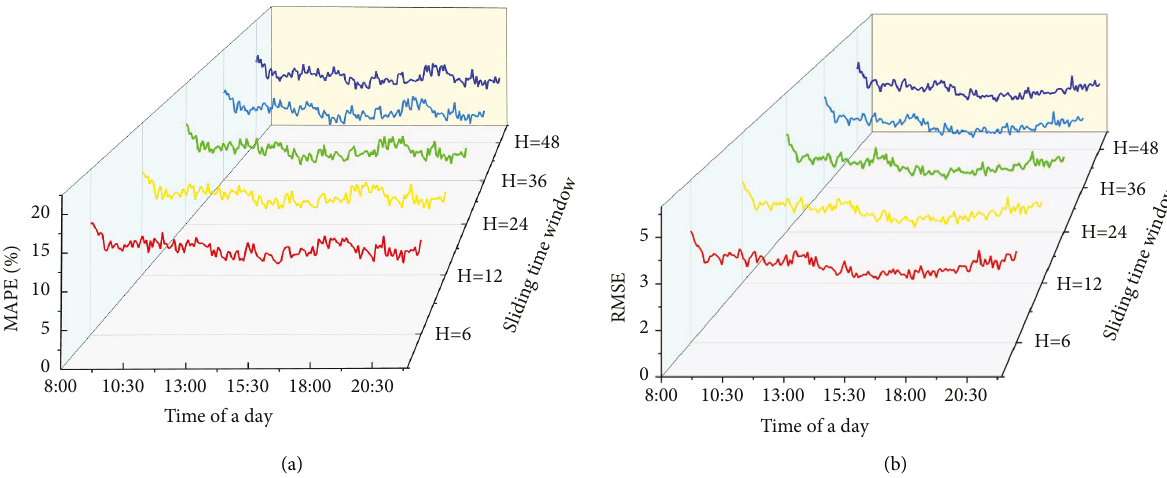
Figure 12: Average estimation speed of different time intervals with different sliding time windows. (a) MAPE; (b) RMSE.